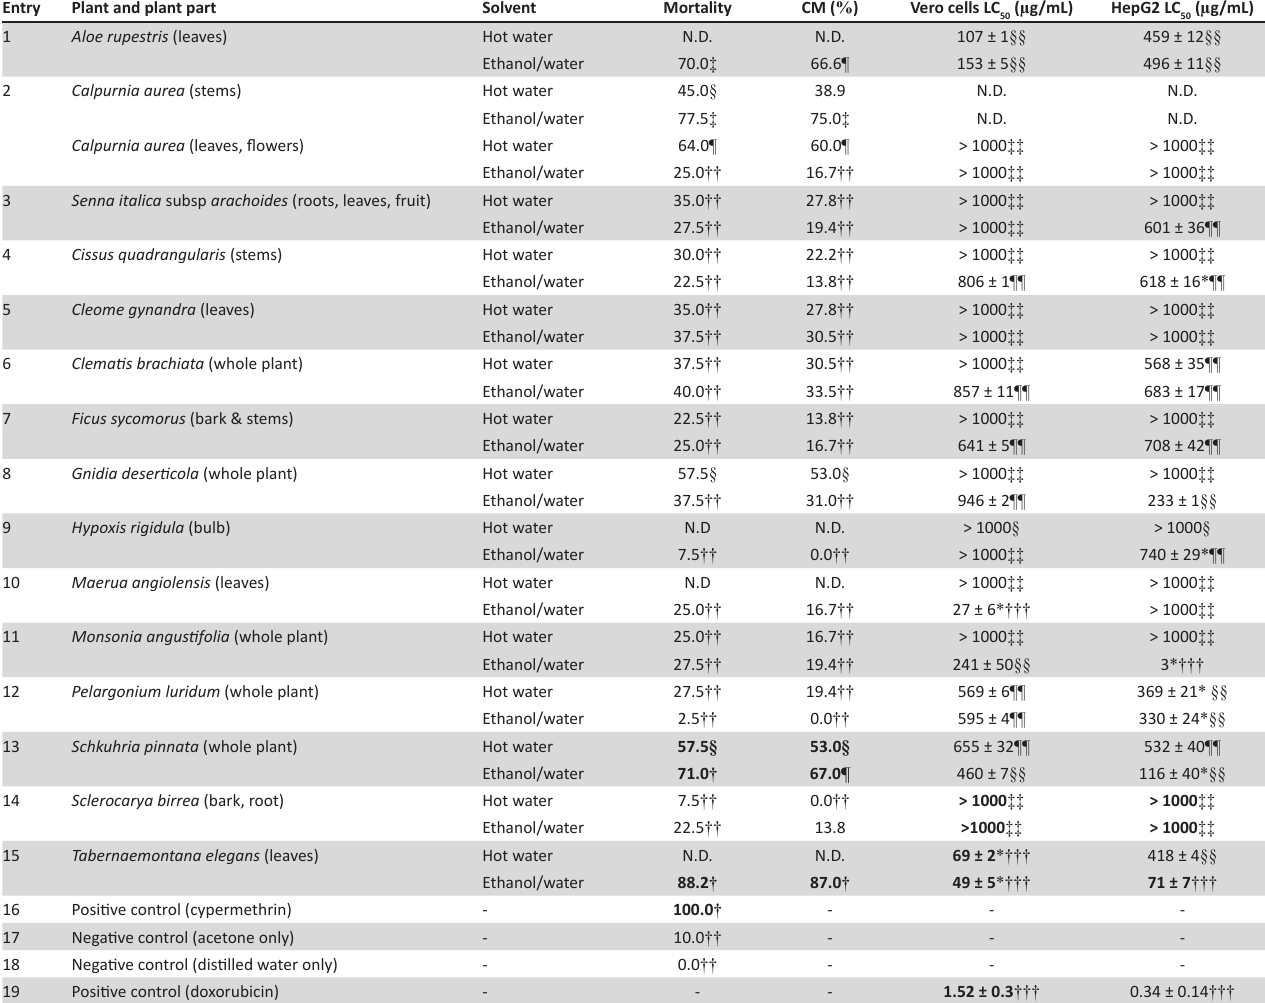
TABLE 2: The mortality, corrected mortality and toxicity of the fifteen indigenous South African plant species screened against R. turanicus . Entry Plant and plant